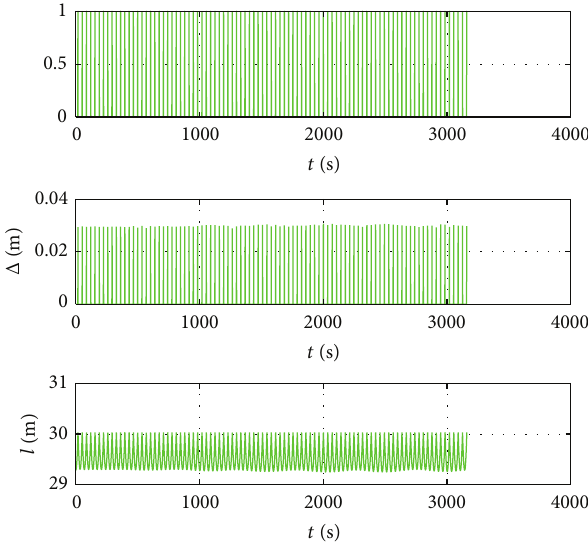
Figure 23: The tensional and tensionless states, the elongation of the tether, and the distance between the two spacecraft.